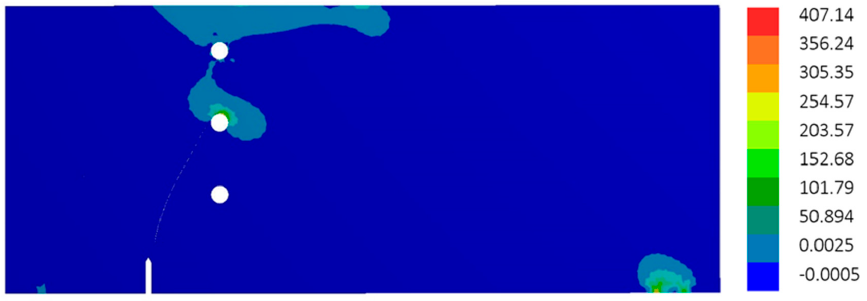
Figure 14. Von Mises stress distribution of case II for the PMMA specimen. The findings of the study for the dimensionless stress factor were compared with those achieved in XFEM with the smooth nodal stress system [37], as seen in Figure 15, with identical results.